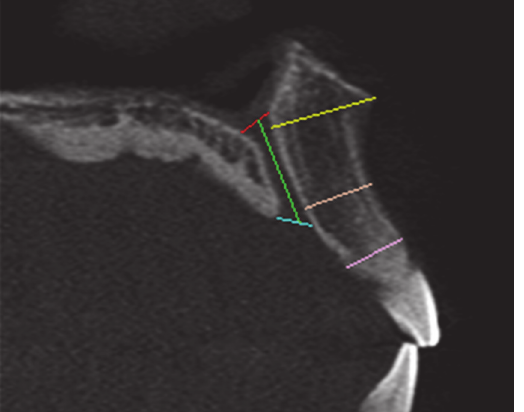
Fig 2. Measurement of the incisive canal length (green line) and anterior maxillary bone thickness at 3 levels (yellow, orange & pink lines).